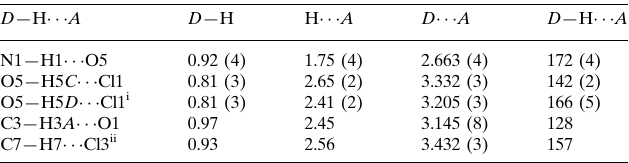
Hydrogen-bond geometry (A˚ , (cid:3)